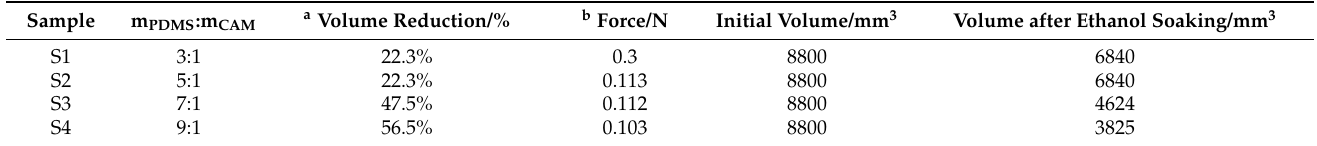
Table A1. Effect of the CAM addition on PDMS sponge.